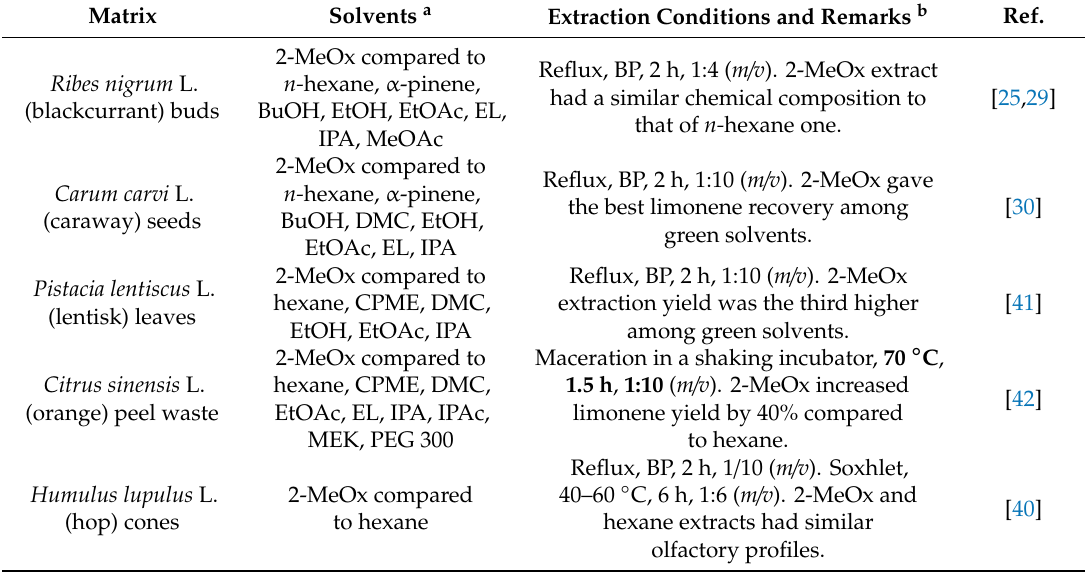
Figure 4. Representation of the predicted solubilities of some aroma compounds in n -hexane and 2-MeOx and their corresponding sigma surfaces, given by COSMO-RS. Rating: 0–20% bad solvent; 20–60% average solvent; 60–100% good solvent. Table 2. Flavors and Fragrances